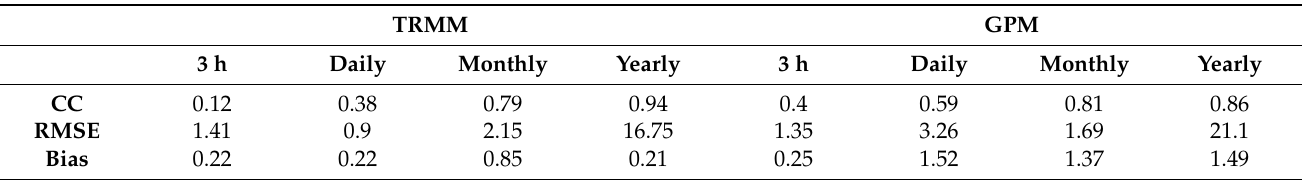
Table 2. Statistical metrics results of 3B42 V7 and IMERG V5 precipitation estimates at multiple time scales from 2012 to